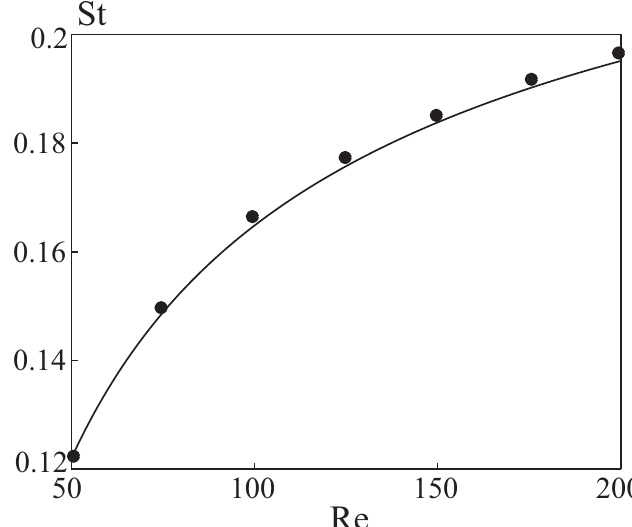
Figure 5. Comparison of calculation results (symbols • ) of the Strouhal number with experimental data [15] (solid